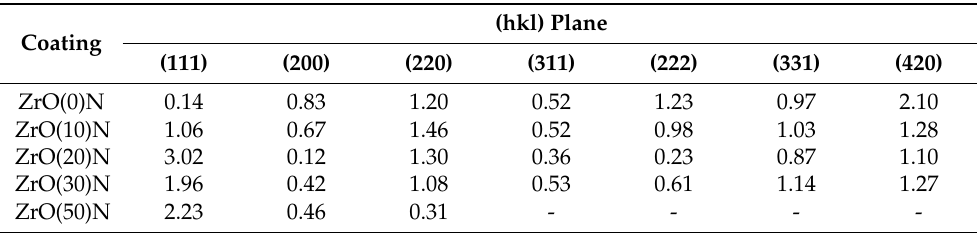
Table 3. Texture coefficient Tc(hkl) for the coatings tested.